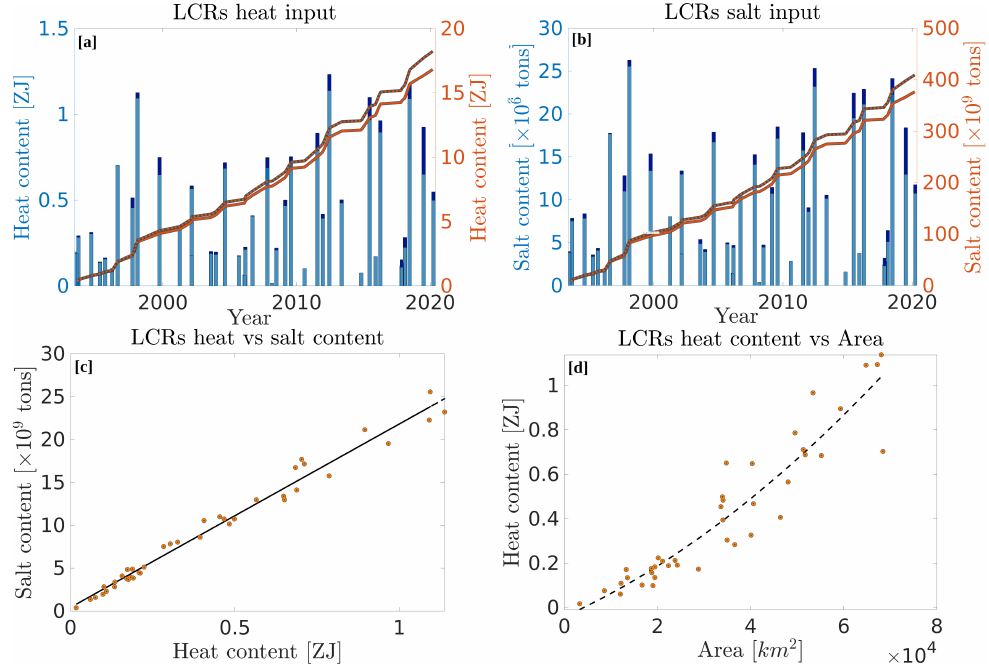
Figure 15. ( a ): Total heat content of each detached Loop Current ring (bar plot). The light blue bars represent values computed using the maximum velocity contour as the LCR’s edge, while dark blue bars were obtained using the last closed absolute dynamic topography (ADT) contour. The orange curves, referenced on the right-hand side y -axis, represent the cumulative heat input of the LCRs over time. The plain and dotted lines represent the maximum velocity and the last closed contour criteria, respectively. ( b ): same as panel ( a ) for the salt input. ( c ): Total heat content of each detached LCR against total salt content. ( d ): Total heat content of each LCR against its total